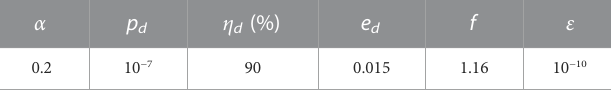
TABLE 1 List of experimental parameters applied in the numerical simulation. Here, α denotes the fi ber loss coef fi cient ( dB / km ), p d is the dark count rate of David ’ s detectors, η d is the detection ef fi ciency of the David ’ s detectors, e d is the opticalmisalignment-errorprobability, f istheerrorcorrectioninef fi ciency,and ε is the security bound when considering statistical fl uctuation analysis.